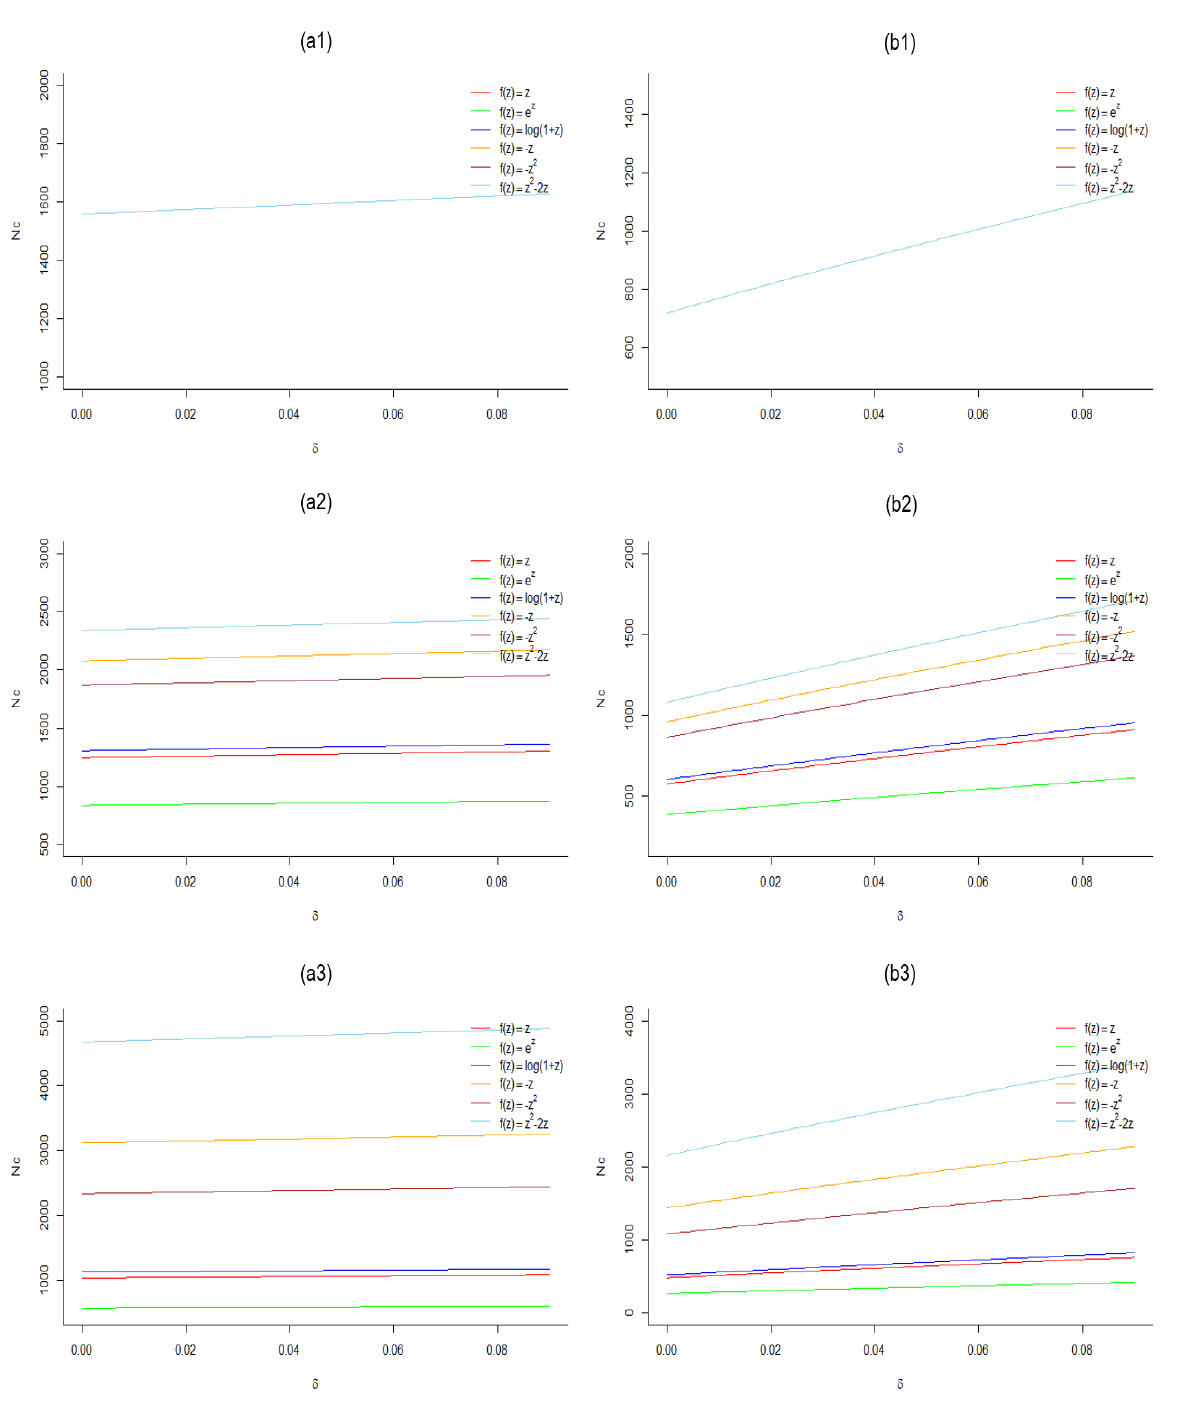
Figure 6. For different changeable gravity functions, relationship between N c and δ , for (cid:101) = 0 and M 3 = 1 in ( a1 ), for (cid:101) = 0 and M 3 = 20 in ( b1 ), for (cid:101) = 0.5 and M 3 = 1 in ( a2 ), for (cid:101) = 0.5 and M 3 = 20 in ( b2 ), for (cid:101) = 1 and M 3 = 1 in ( a3 ), for (cid:101) = 1 and M 3 = 20 in ( b3